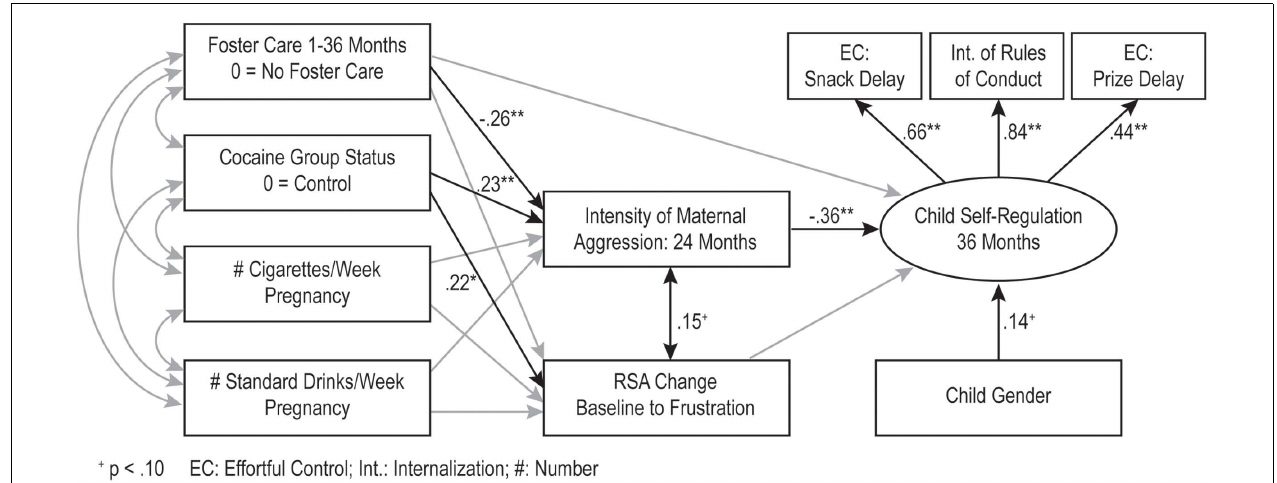
FIGURE 1 | * p < 0.05; ** p < 0.01.The indirect effects model ( n = 216). The numbers represent standardized path coefficients. Non-significant paths included in the model are in gray.The covariances between the exogenous variables are depicted in Table 2 .The error terms for the measured indicators are not depicted in the